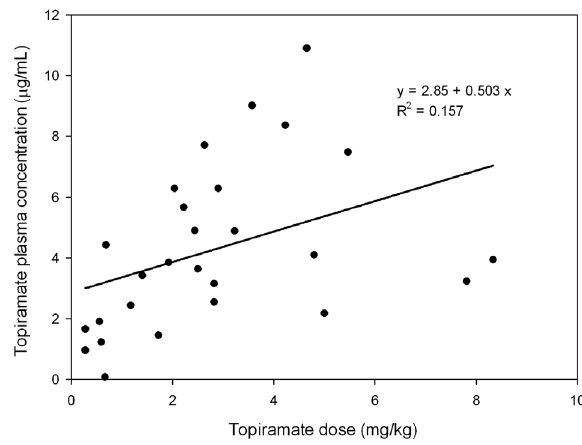
Figure 4 : The relationship between steady-state TPM trough con- centration and TPM dose per body weight in 27 patients with epi- lepsy on stabile TPM therapy 50–400